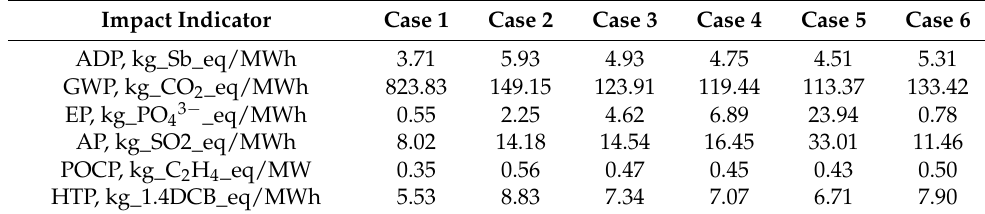
Table 7. Values of impact indicators relative to 1